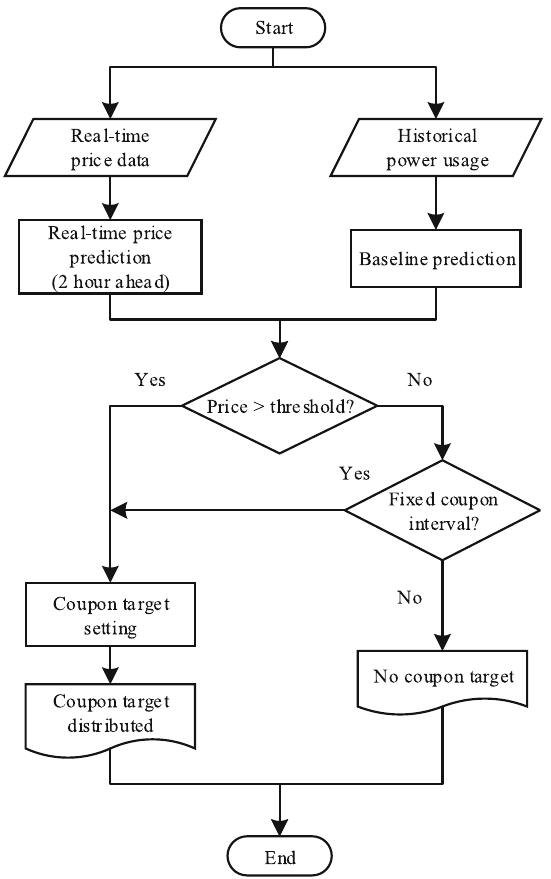
Fig. 4 EnergyCoupon algorithm flow chart